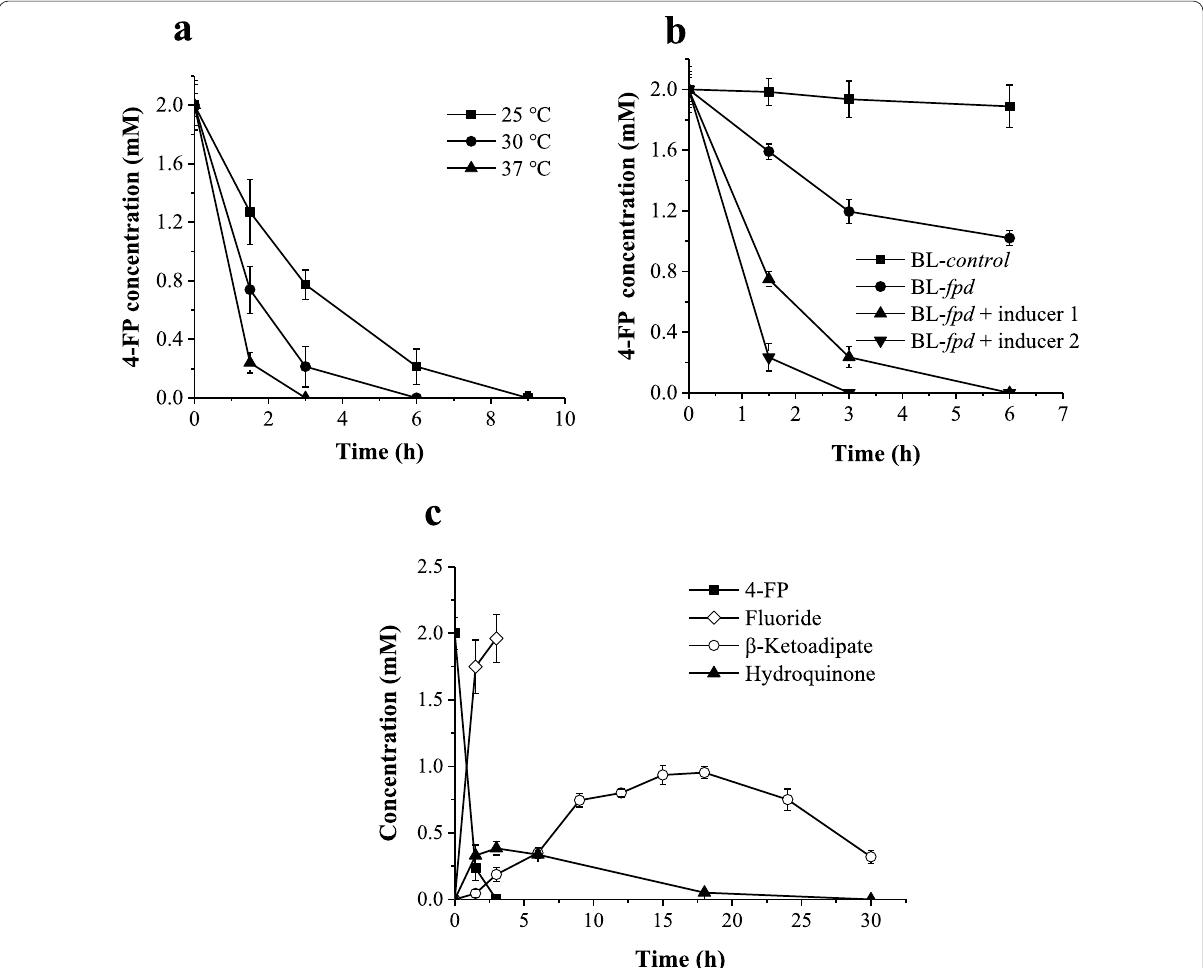
Fig. 3 Degradation of 4-FP by BL- fpd . a Optimization of induction temperature under inducer 2; b Optimization of inducer concentration at 37 ℃ ; c Time-course curve of 4-FP degradation metabolites by BL- fpd under optimized conditions (37 ℃ , inducer 2) . The data are the mean independent